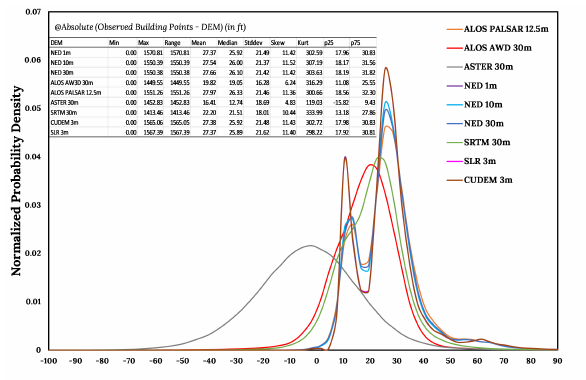
Figure 10. The distribution of elevation differences for all considered datasets with histogram curves and statistical